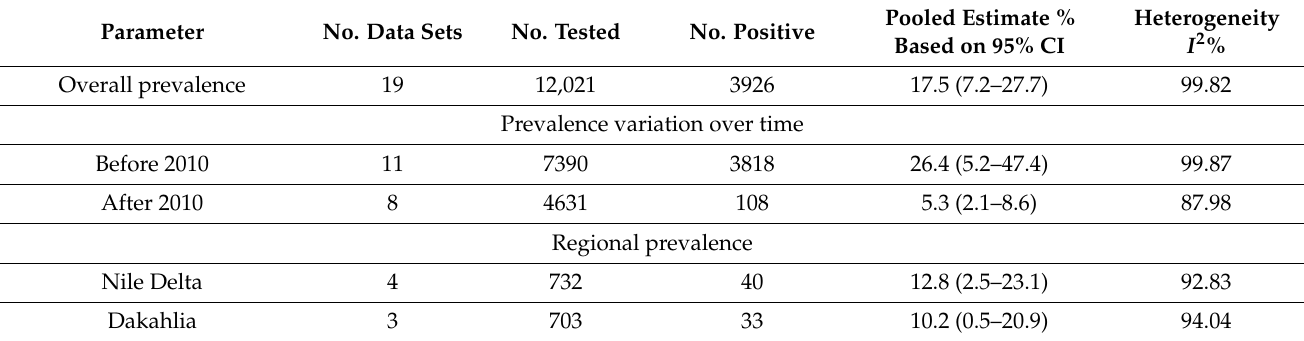
Table 6. Overall and regional pooled prevalence of Taenia spp. detected in dogs from various Egyptian regions, and variabilities according to dog life